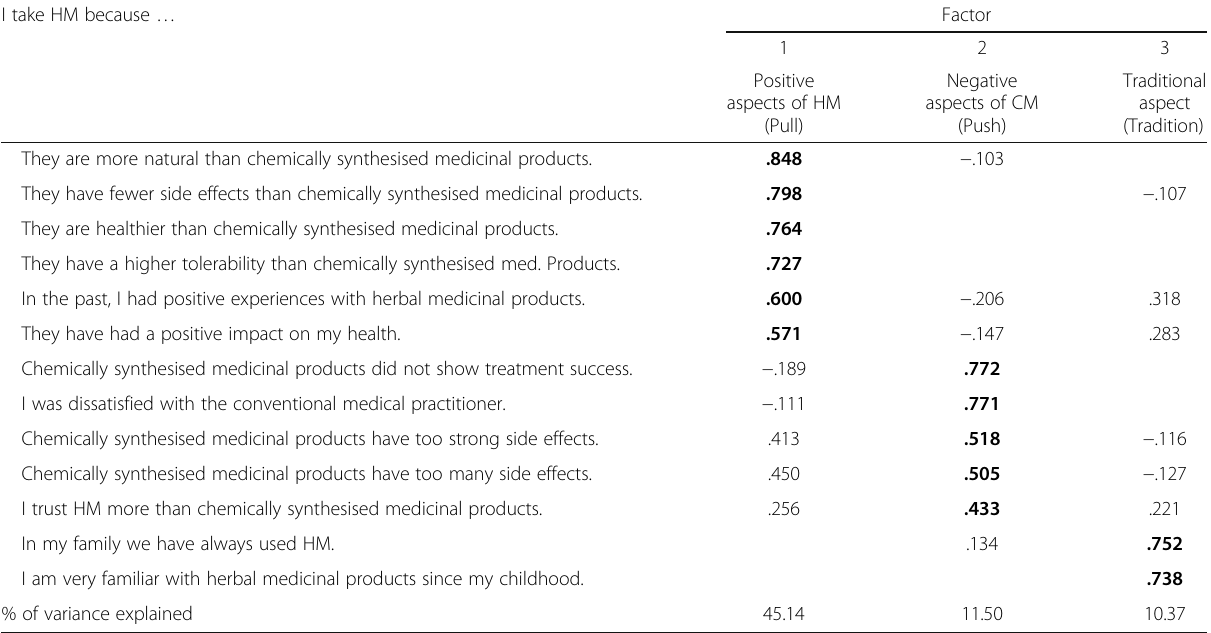
Table 3 Results of factor loadings using principle axis factor analysis with promax